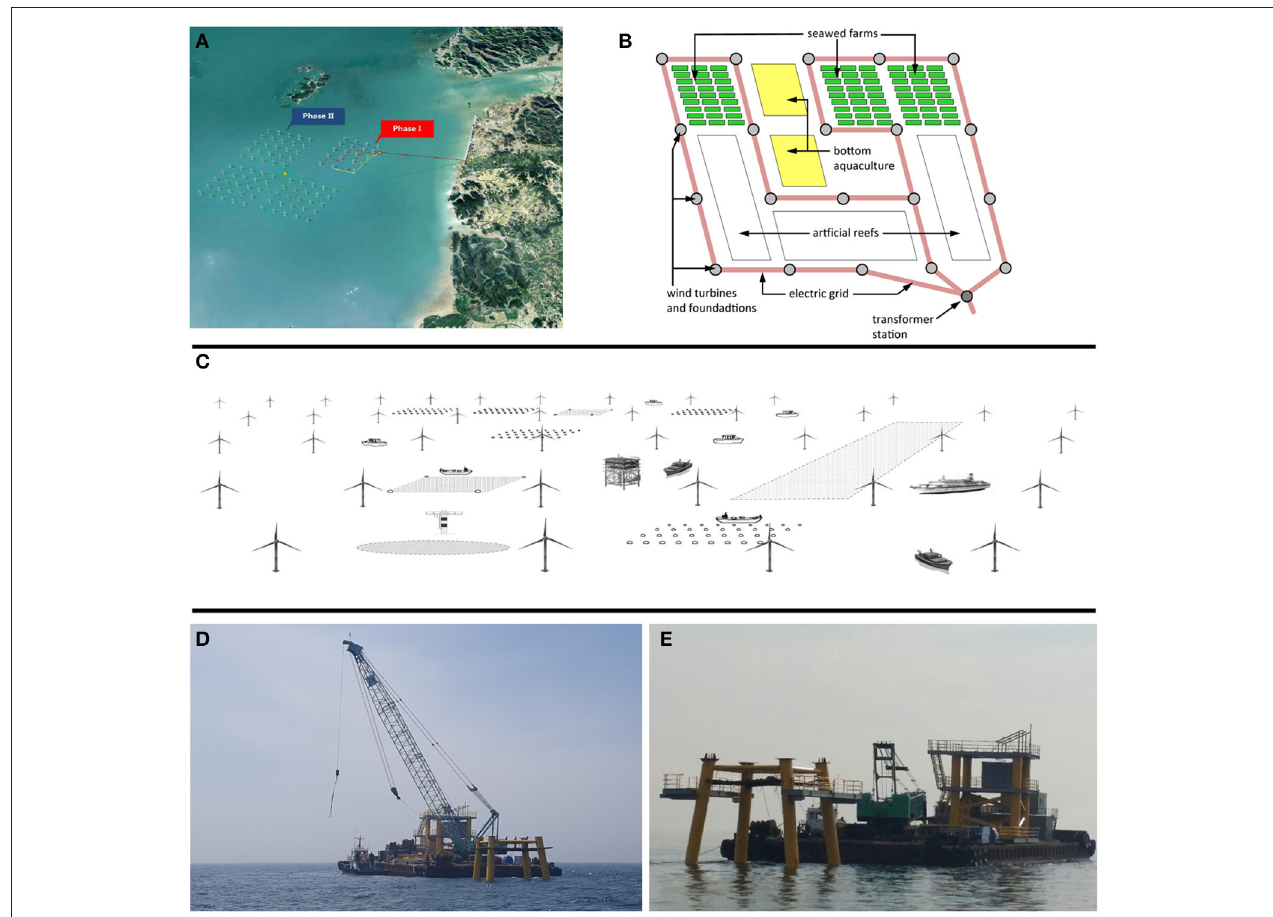
FIGURE 4 | (A–E) IMTA concepts as a co-use in offshore wind farms. (A) Aquaculture co-location site within a planned wind farm off the coast of southern-east South-Korea (upper left); (B,C) drawings of the multi-use concepts at the wind farm site as an internal aquaculture layout (upper right) and shown in a profile view, including fish, seaweed and oyster cultivation (centered); (D,E) Deployment of the foundation of an offshore wind turbine within the co-location site of a wind farm, using attachment device for multi-uses (lower left and right) [Images (A–E) with permission of the publisher modified after (Buck et al.,